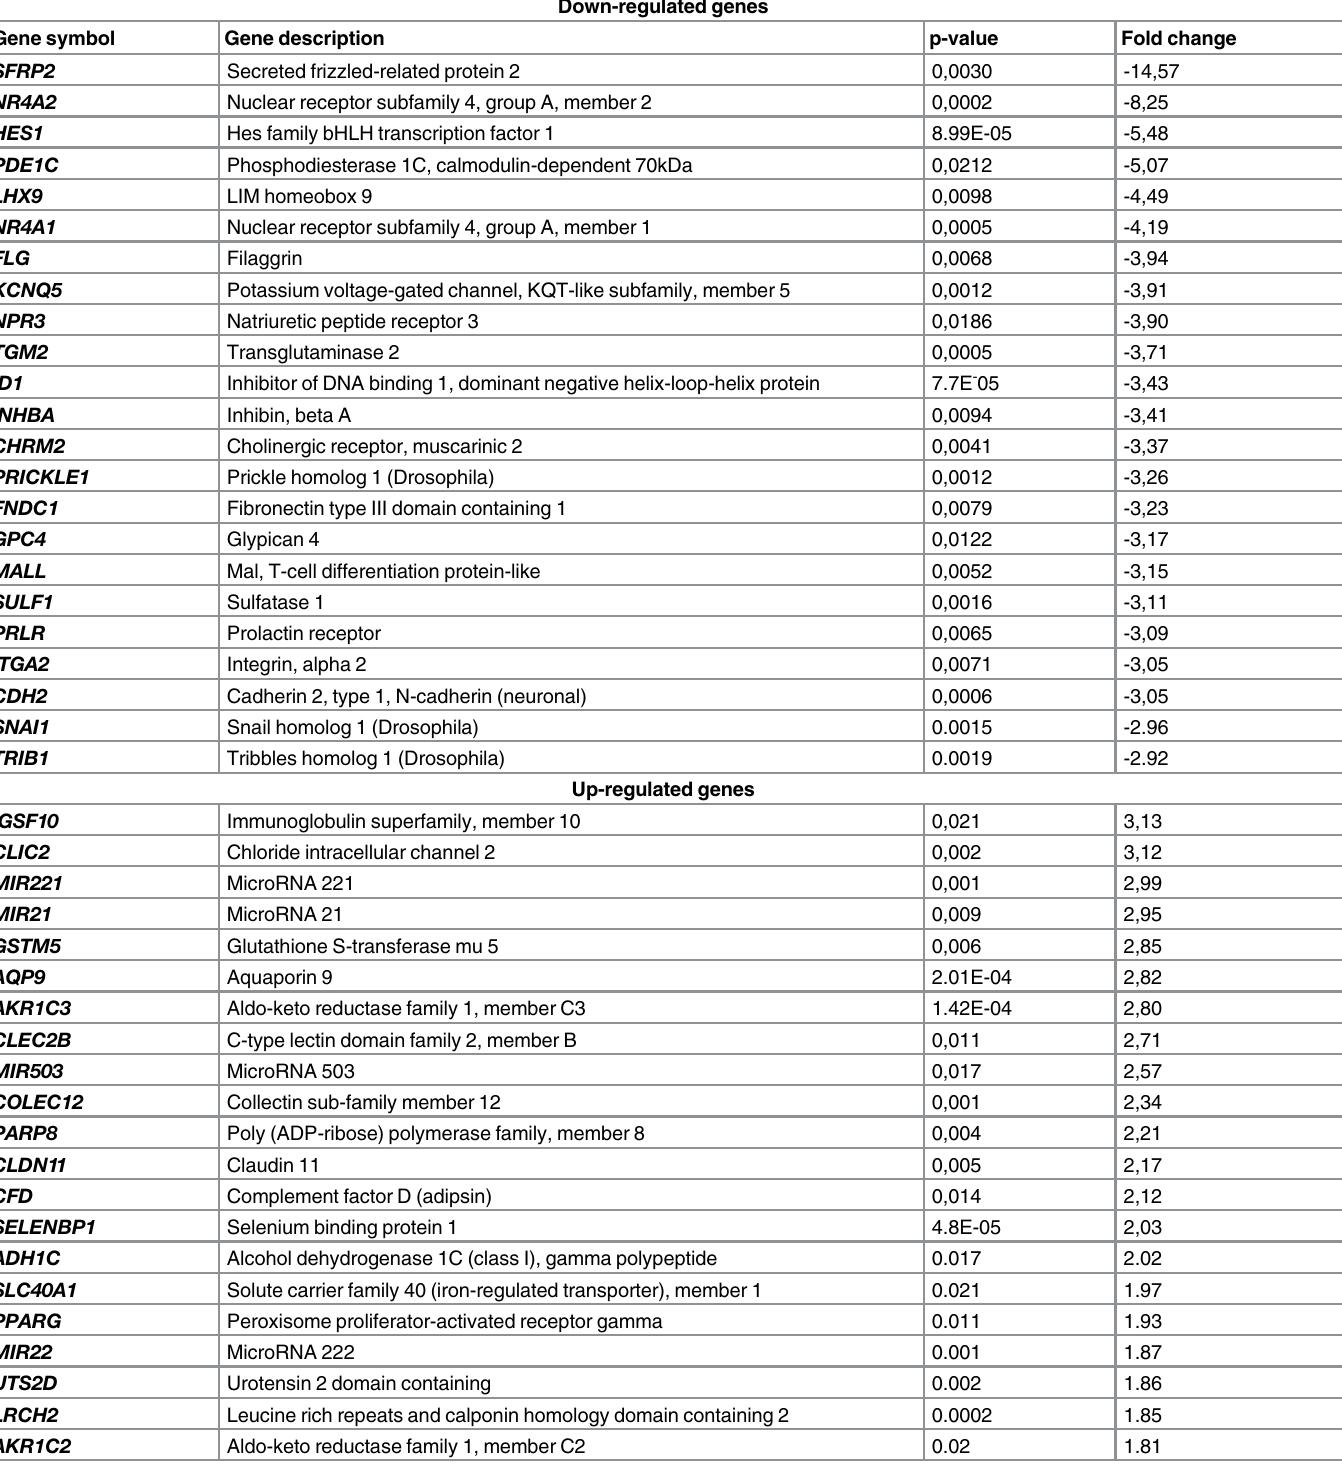
Table 2. Selection of DEGs in JHS/EDS-HT skin